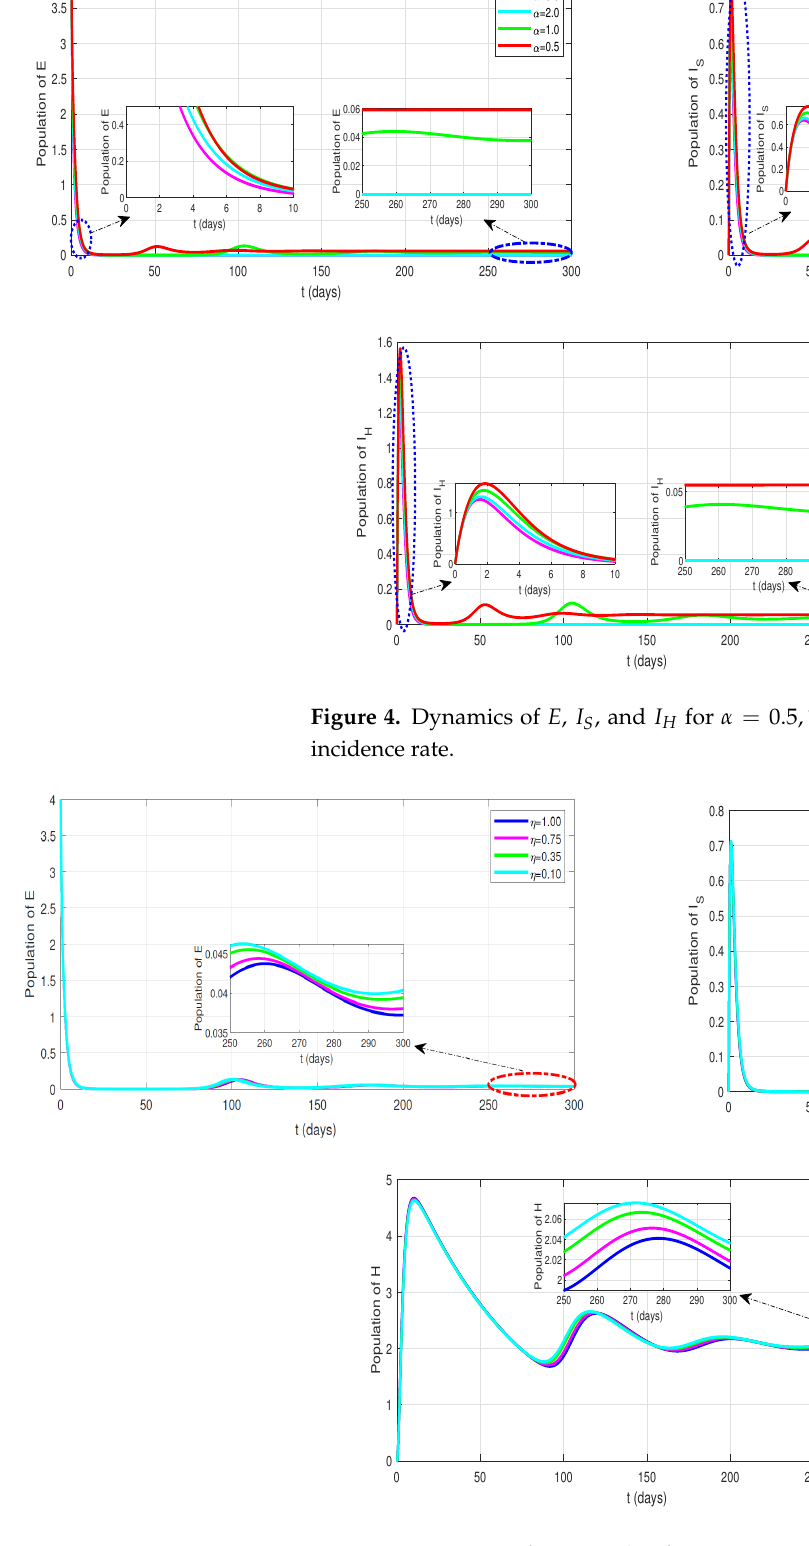
Figure 5. Dynamics of E , I S , and H for η = 0.10,0.35,0.75 and 1.00 showing the effect of incomplete treatment at